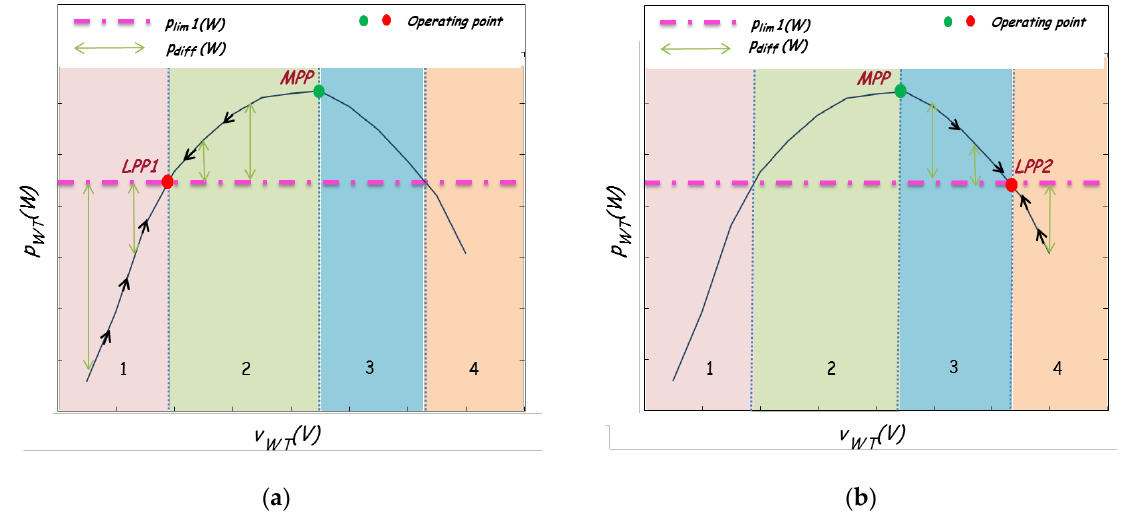
Figure 5. Operating cases for ( a ) limited power point 1 (LPP1); ( b ) LPP2.